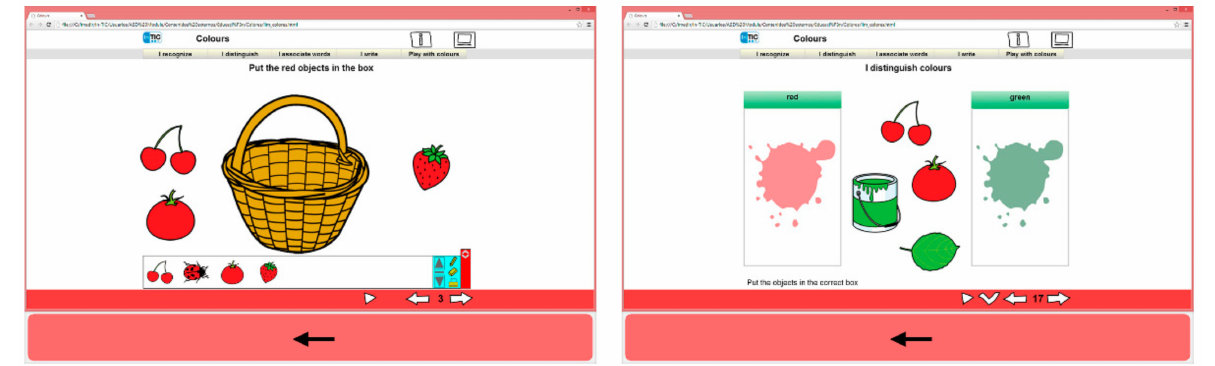
Figure 3. Examples of LIM activities using colours for the Education